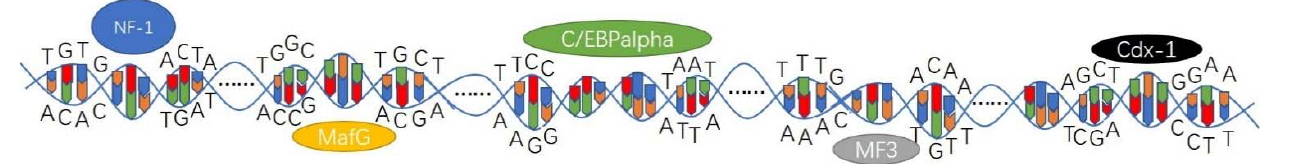
Figure 1. Schematic diagram of binding sites of 5 ′ transcription factors in the regulatory region of OVR in Wanxi White goose.